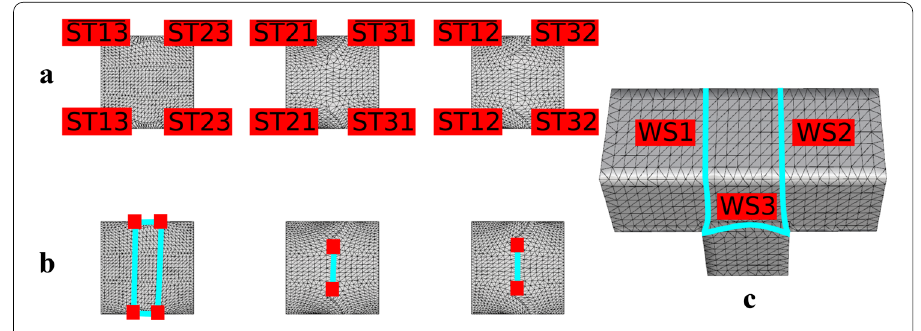
Fig. 8 Feature cutting curves generation. a The three temporary unit square maps U T 3 , U T 1 and U T 2 (left to right). b Partial line inverse mapping using feature cutting points in C performed in U T 3 , U T 1 and U T 2 (left to right). c Computed feature cutting curves W S 1 , W S 2 and W S 3